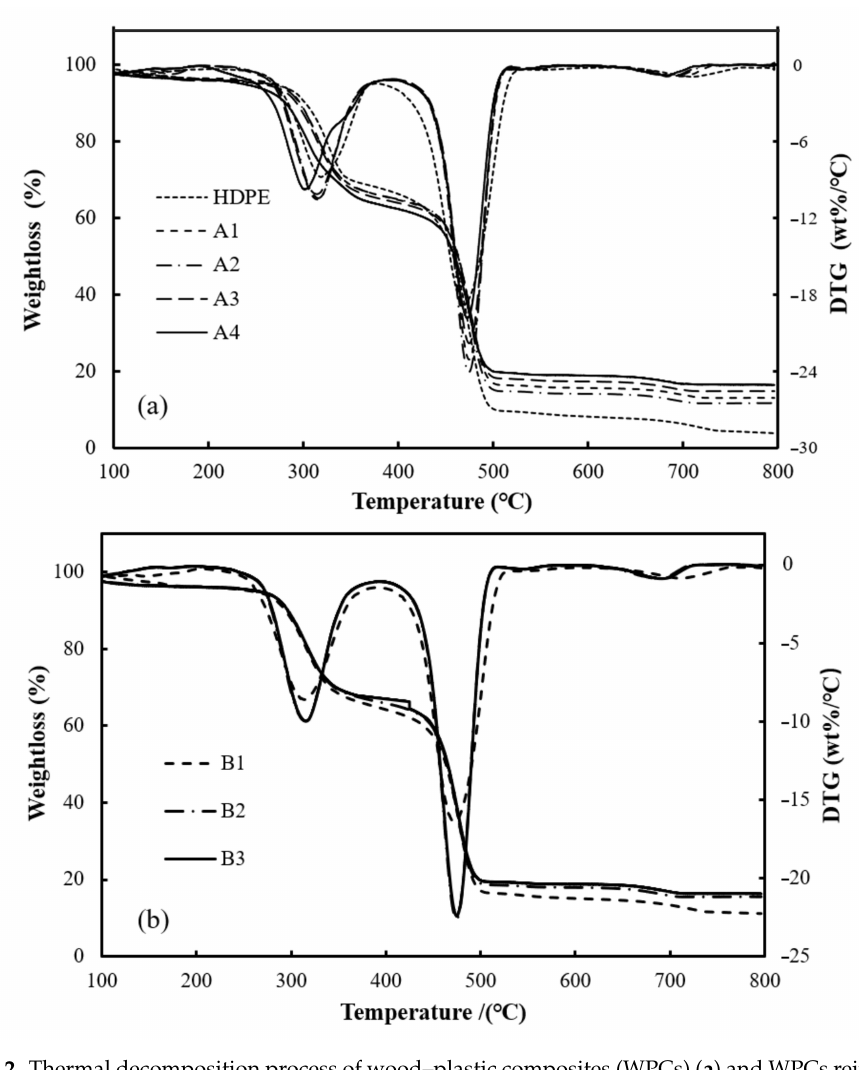
Figure 2. Thermal decomposition process of wood–plastic composites (WPCs) ( a ) and WPCs reinforced with BFs ( b ) at a heating rate of 20 ◦ C / min.